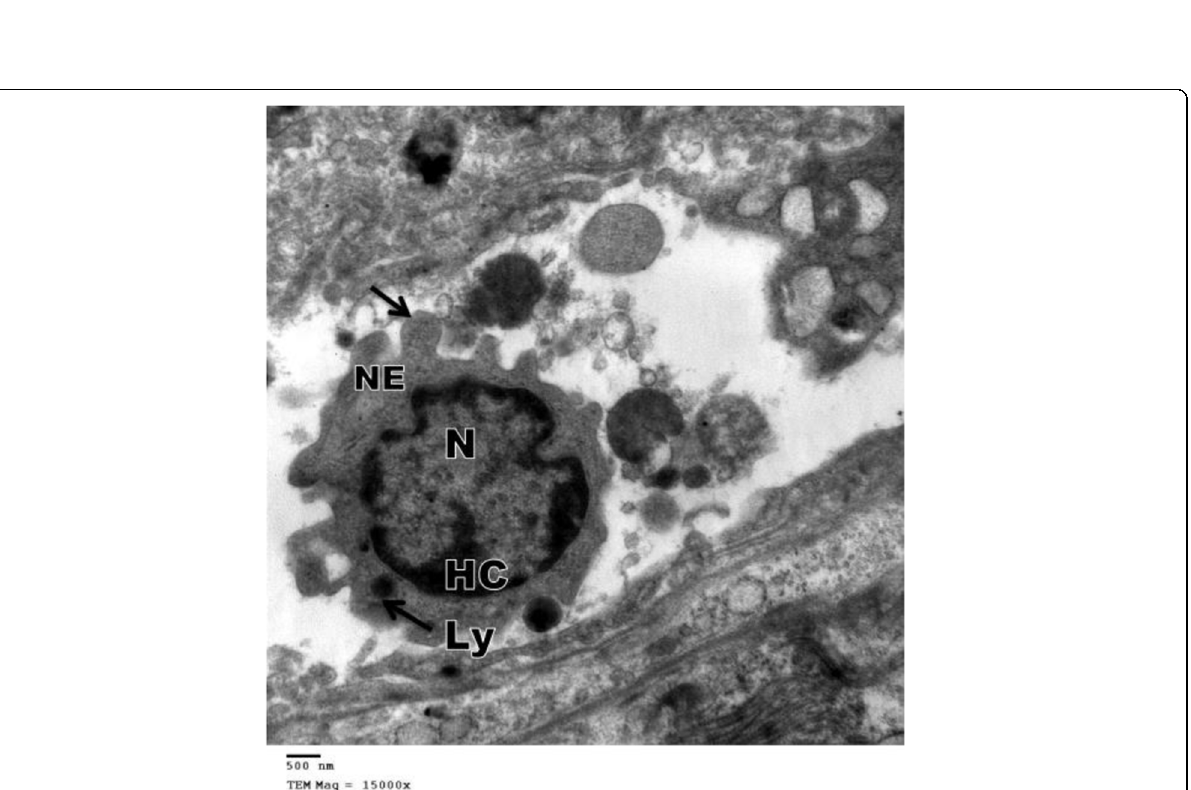
Fig. 27 An electron micrograph of a Kupffer cell of treated mouse with Tamiflu (16 mg/kg b.wt.) in addition to Adamine (20 mg/kg b.wt.) for 5 days revealing fillopodia in cell membrane of Kupffer cell (arrow), lysosomes (Ly), and nucleus (N) with irregular nuclear envelope (NE) had heterochromatin (HC) attached to inner membrane of the nuclear envelope. (× 15,000)